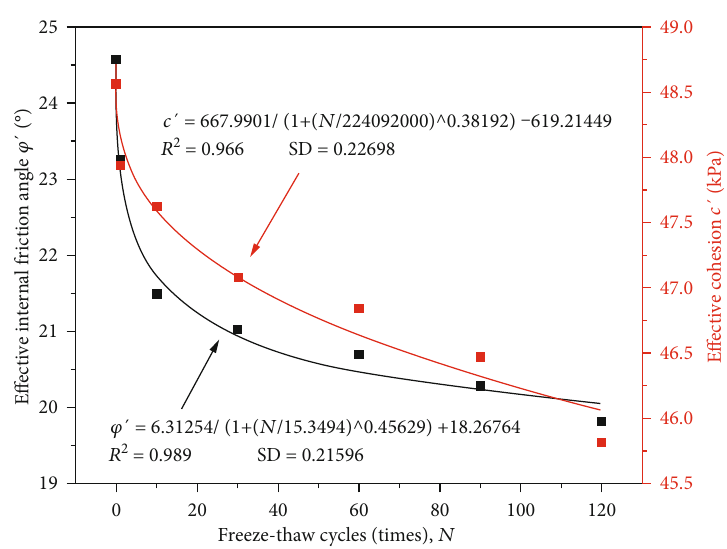
Figure 11: Fitting curves of c ′ and ϕ ′ under freeze-thaw